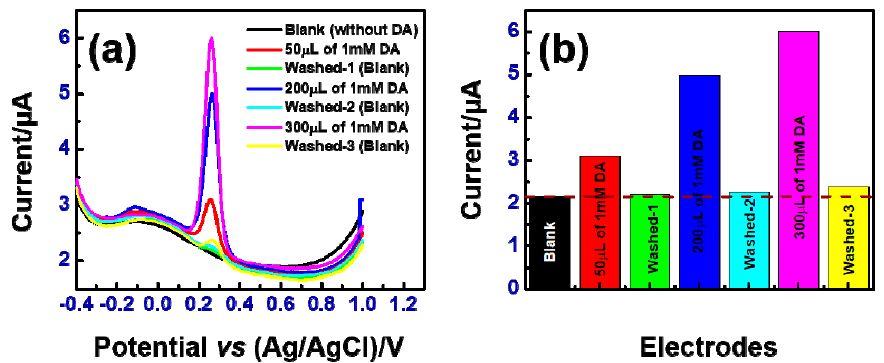
Figure 9. (a) The recovery test of the biosensors; (b) Current changes response of the